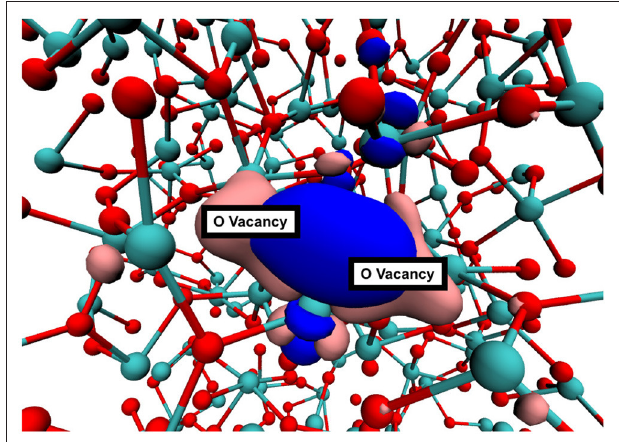
FIGURE 4 | A typical oxygen di-vacancy in a-HfO 2 . The pink and blue surfaces show the | ψ | 2 of the defects states. In this configuration, the vacancy states combine and look similar to bonding and antibonding